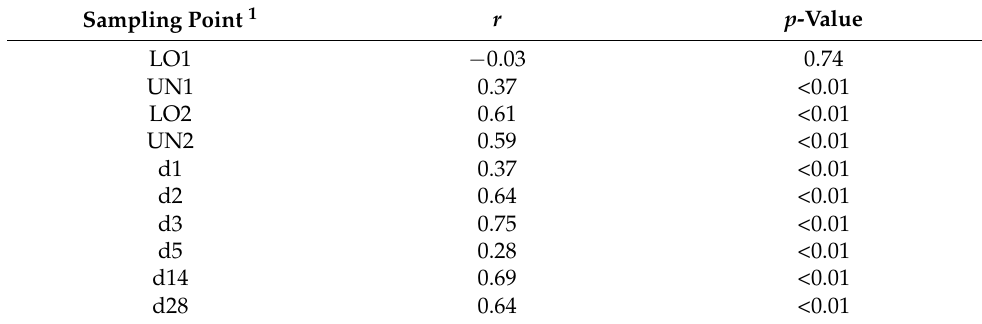
Table 1. Pearsons’s product-moment correlation between Lactate Scout+ analyzer and a colorimetric assay at each sampling point (pooled data).